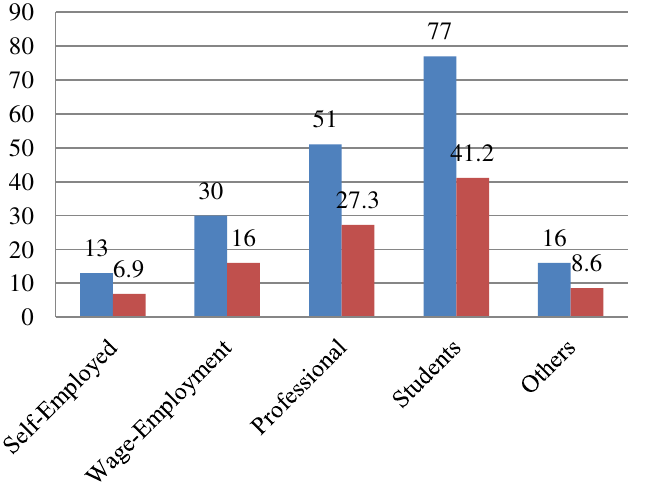
Fig. 3. Employment status percentage of research